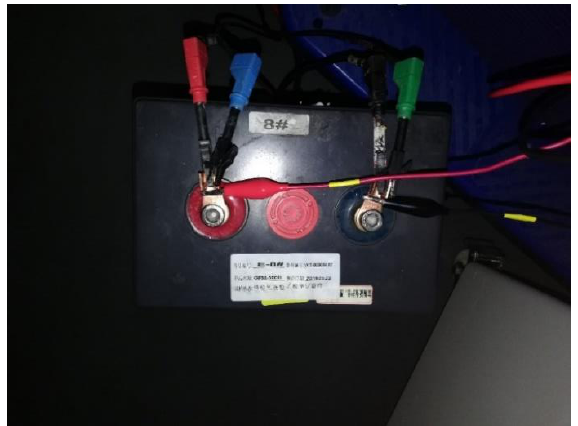
Figure 5. Tested battery E-08#. Appl. Sci. 2019 , 9 , x FOR PEER REVIEW